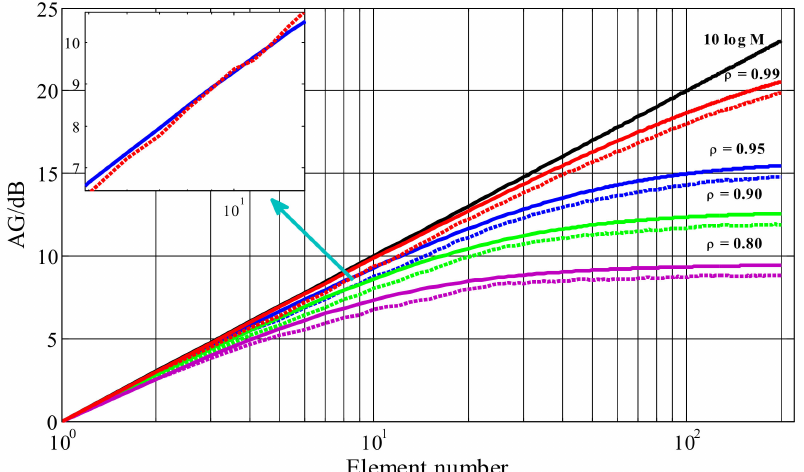
Figure 1. AG U (colorful solid line) and AG W (dash line) as a function of the number of elements for different ρ , with the black solid line showing the ideal value of